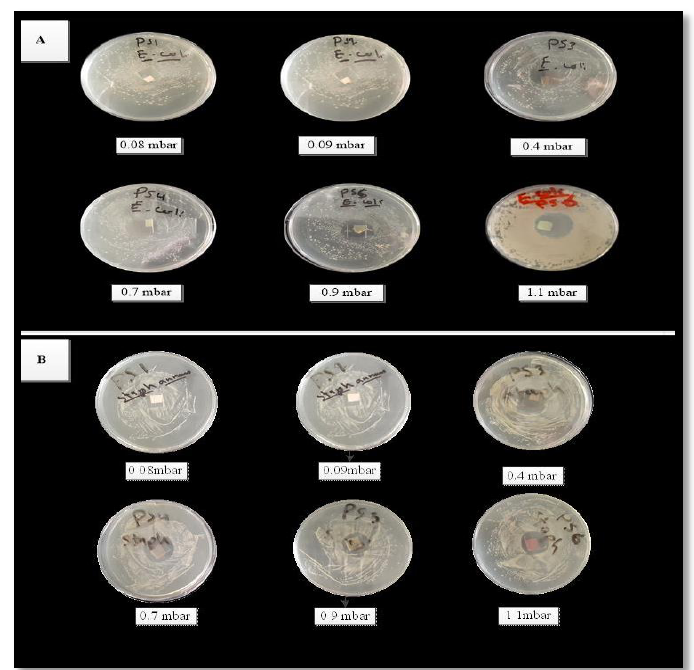
Fig. 6: Antimicrobial activity for Ag nanoparticles deposited at different work pressures on A: Escherichia coli B- staphylococcus